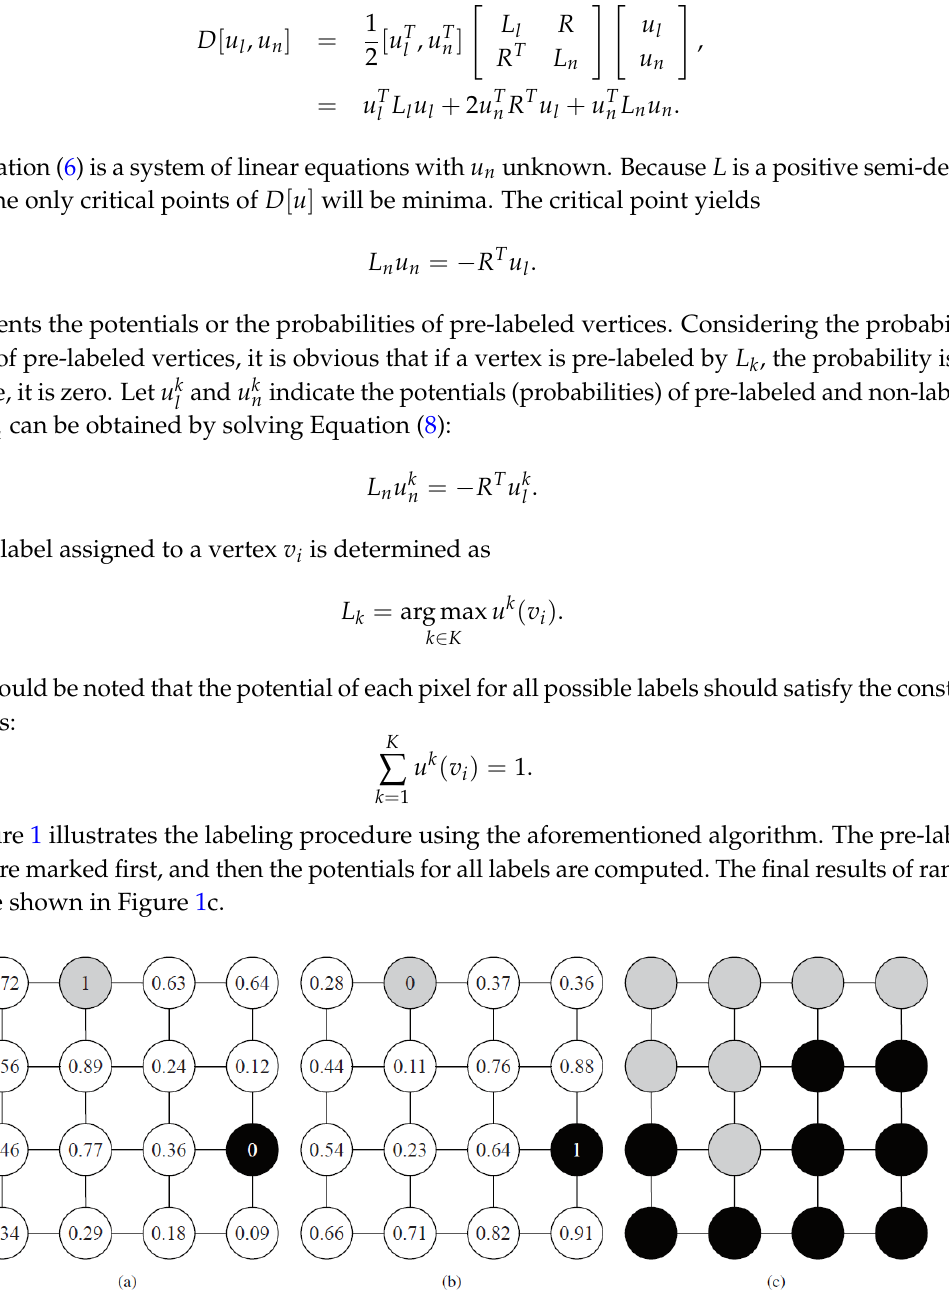
Figure 1. The labeling procedure using random walks. The vertices pre-labeled with two labels are separately marked with gray and black color. The conditional probability (potential) of each vertex is represented within the circle. ( a ) probabilities that a random walker starting from each vertices. First reaches the pre-labeled gray vertex; ( b ) probabilities that a random walker starting from each vertices. First reaches the pre-labeled black vertex; ( c ) labeled results with the random walk